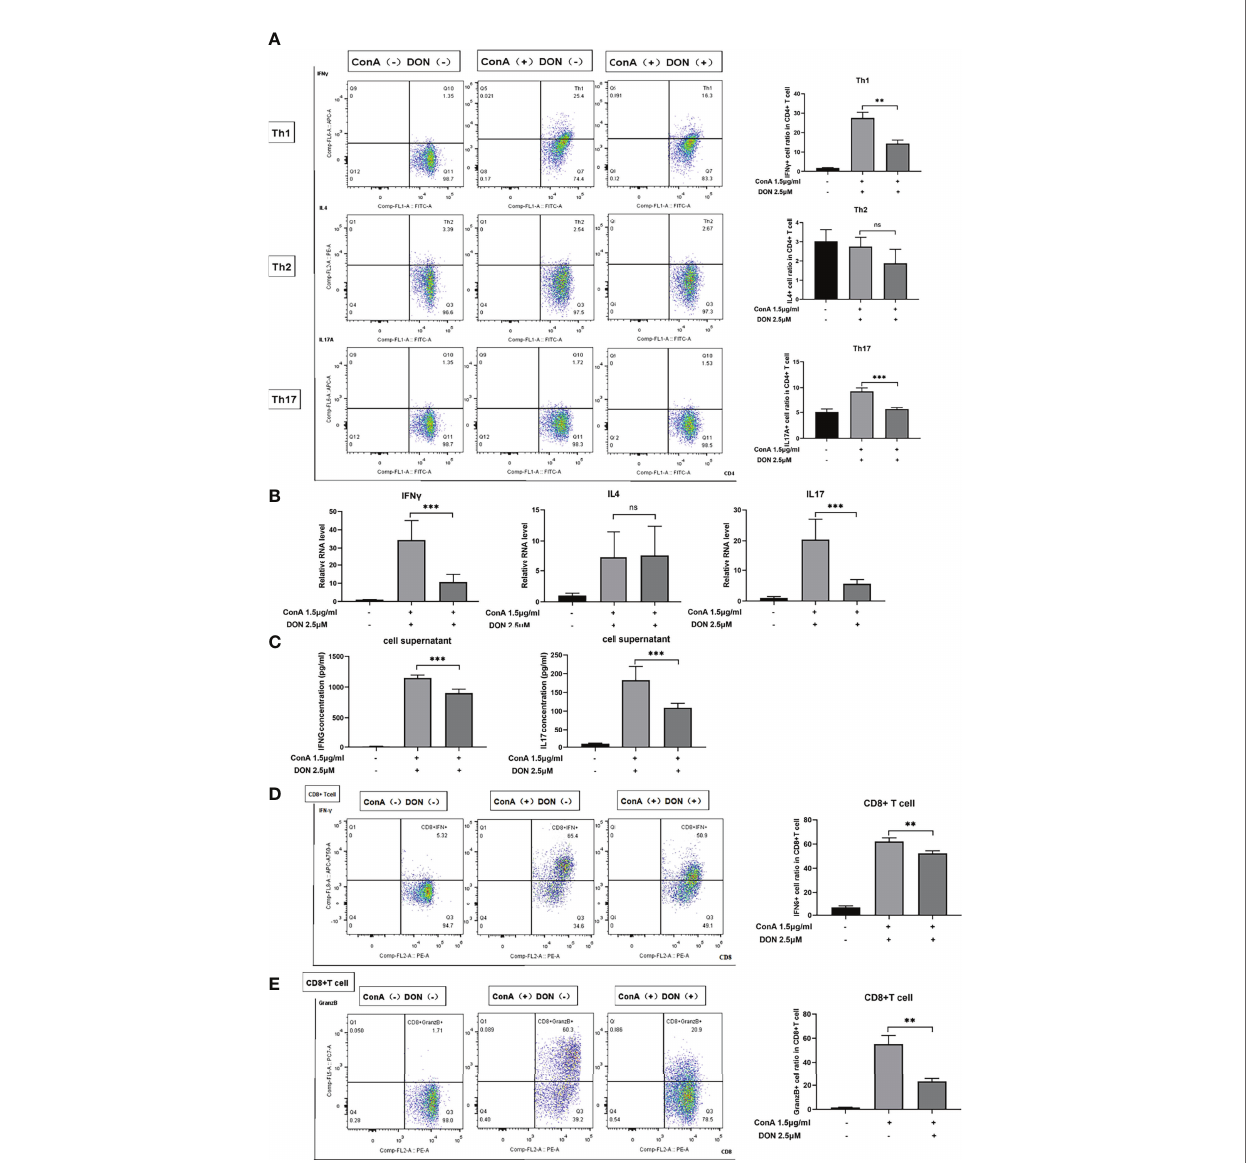
FIGURE 5 | DON treatment suppressed T cells differentiation in vitro . Freshly separated spleen cells were stimulated with 1.5mg/ml ConA with or without treating 2.5 m M DON, and cells were analyzed 24h after ConA stimulation. (A) The differentiation markers of CD4+ T cells (IFN g for Th1 cells, IL4 for Th2 cells and IL17 for Th17 cells) were detected using fl owcytometry. (B) qRT-PCR was applied to analyze IFN- g , IL4 and IL17 mRNA levels. (C) ELISA was applied to analyze supernatant IFN- g and IL17 secretions. Flow cytometry was also applied to detect the production of activation markers of CTL, such as IFN g (D) and Granzyme B (E) . Data were expressed as means ± SEM. ** P <0.01 and *** P <0.001, ns, not signi fi